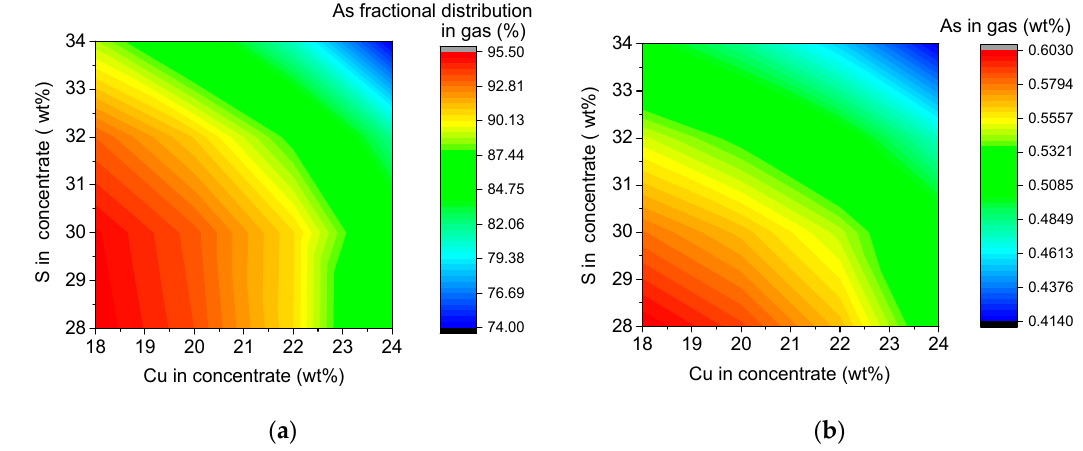
Figure 5. Arsenic distribution in the gas phase: ( a ) fractional distribution; ( b ) mass fraction.